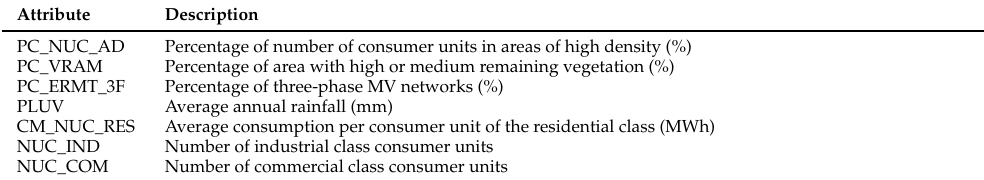
Table 18. Selected attributes for DEC and FEC in